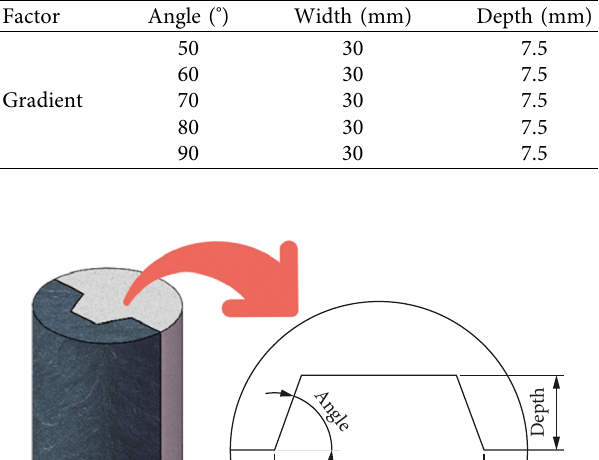
Figure 3: Sample preparation process. Table 1: Test parameter design.